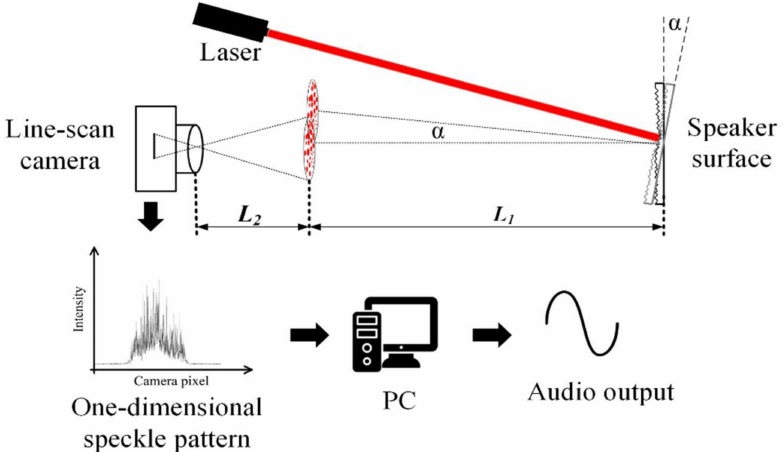
Figure 1. Schematic of the real time audio signal detection system using 1D laser speckle